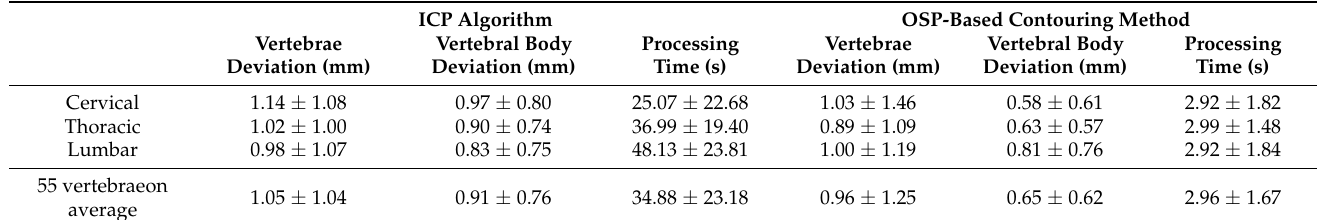
Table 2. Performance and deviation comparisons of the ICP and OSP-based contouring methods. Table 3. Wilcoxon signed-rank test results of pairwise comparisons between the ICP and OSP-based contouring methods.